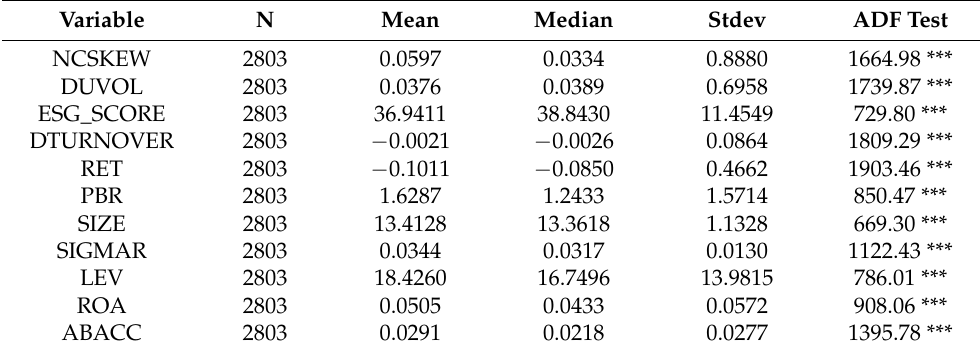
Table 4. Descriptive statistics for Nikkei-225